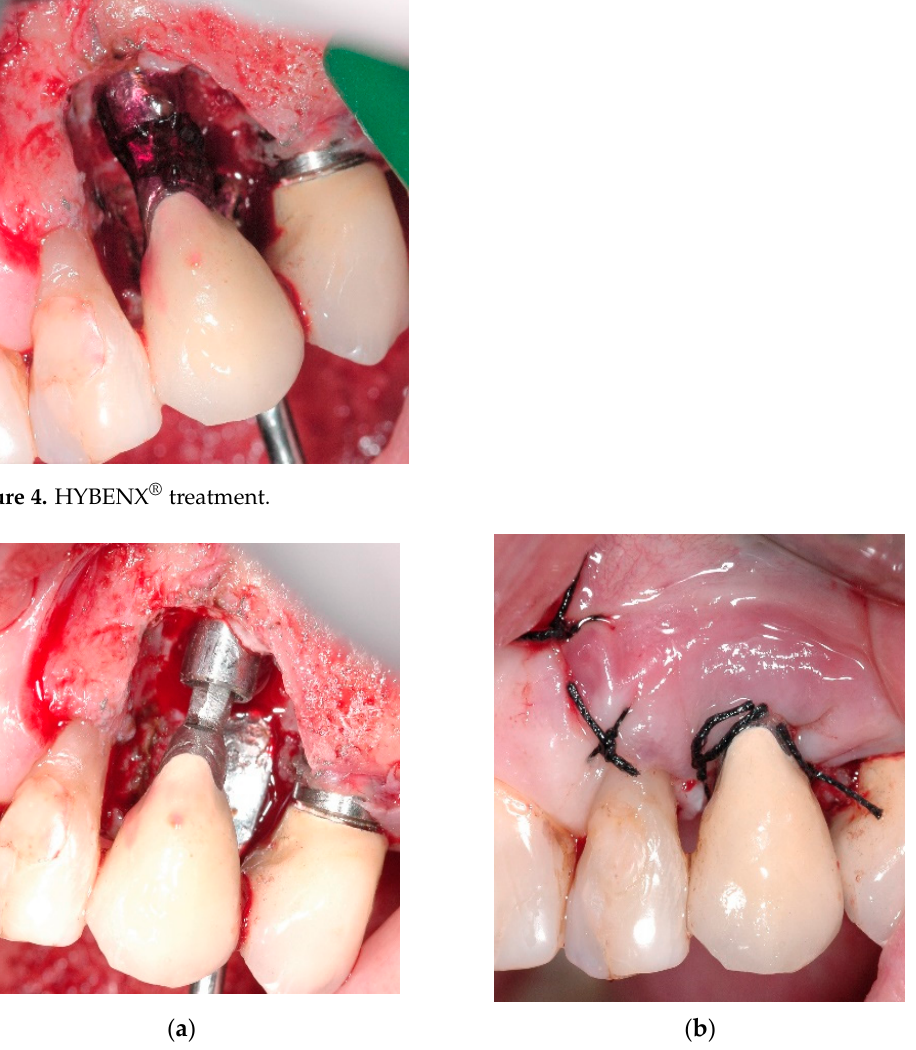
Figure 3. Clinical image after debriding, showing significant bone loss before treatment.